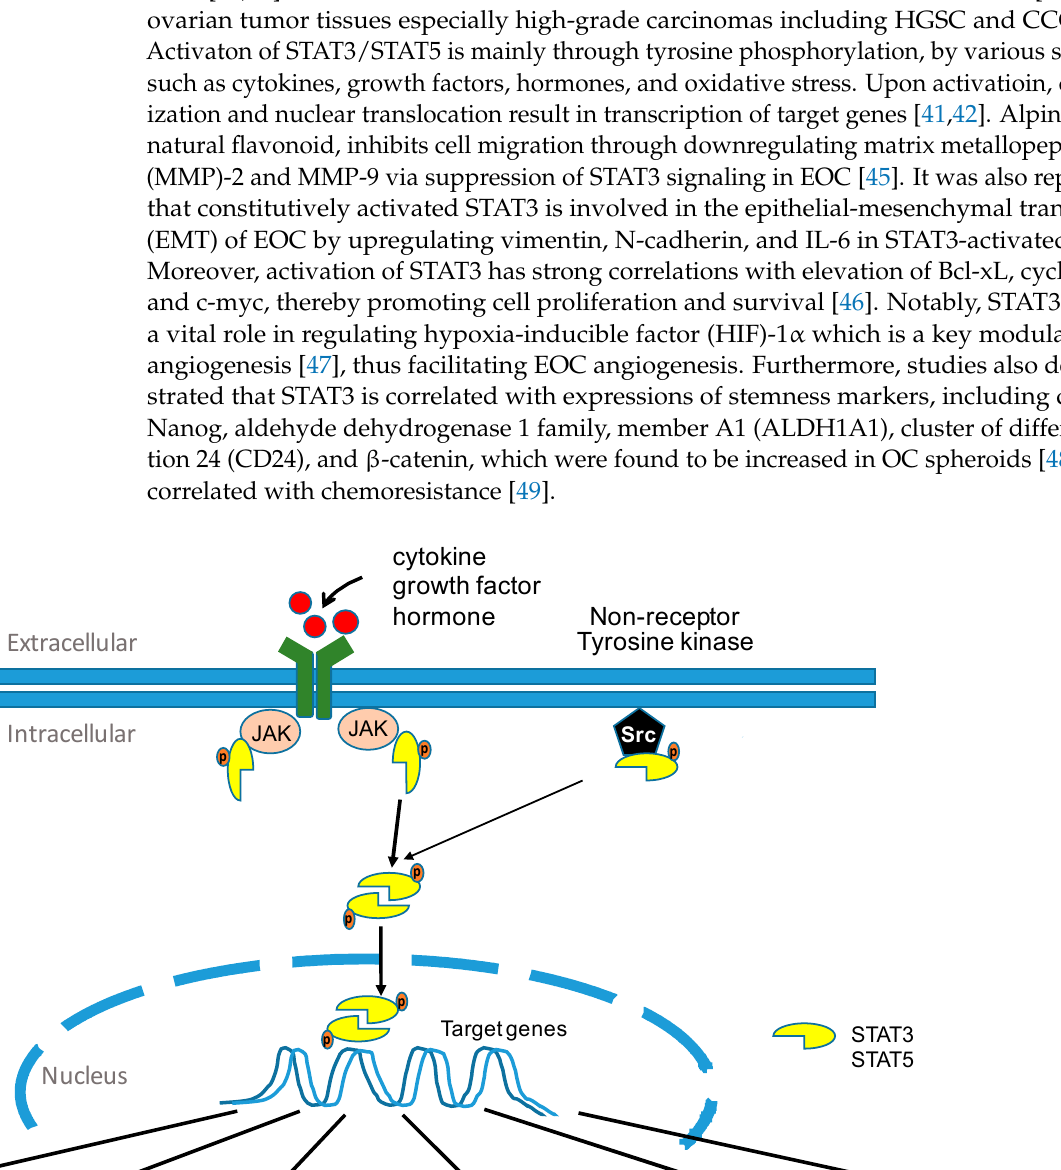
tion was shown by dashed arrows.